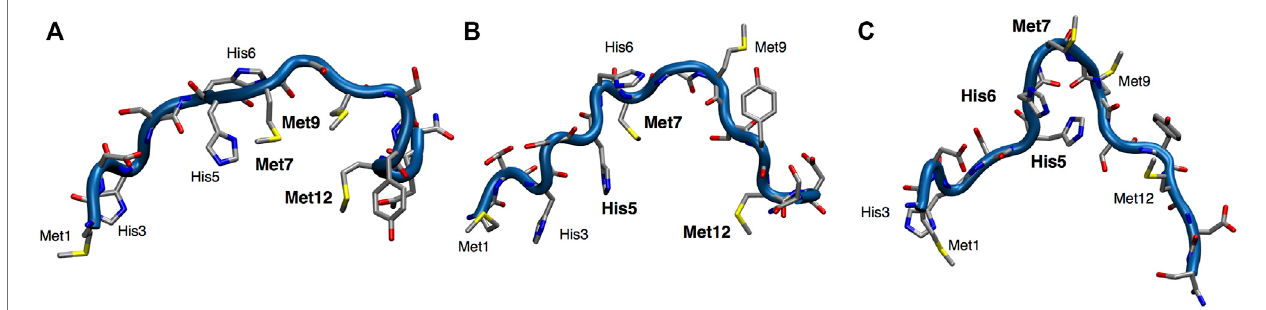
FIGURE 2 | Representation ofthe three main clusters (A – C) extracted from the PBMetaD simulation trajectory. Oxygen is shown in red, nitrogen in blue, carbon in gray and sulfur in yellow.